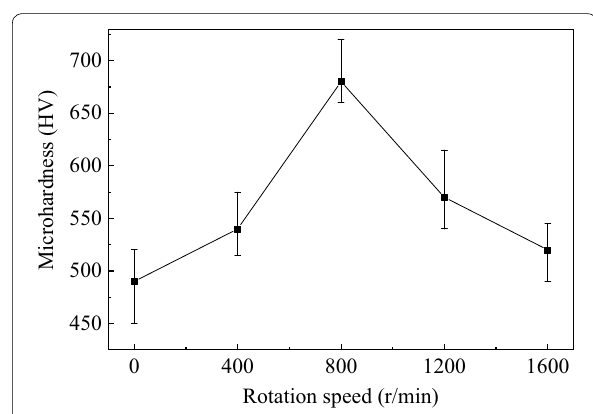
Figure 6 Microhardness values for the Ni-Co/SiC coatings prepared at: a 0, b 400 r/min, c 800 r/min, d 1200 r/min, and e 1600 r/min